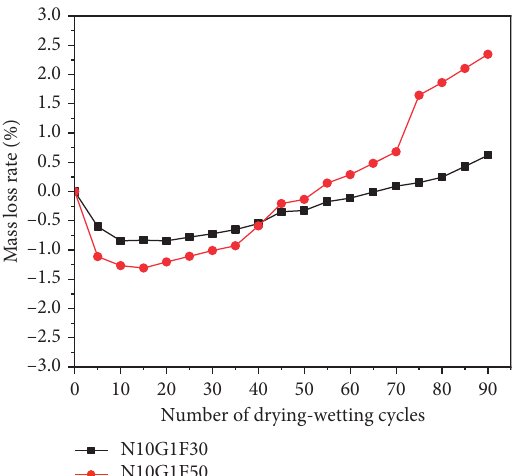
Figure 5: Variation of the mass loss rate of concrete with different fly ash